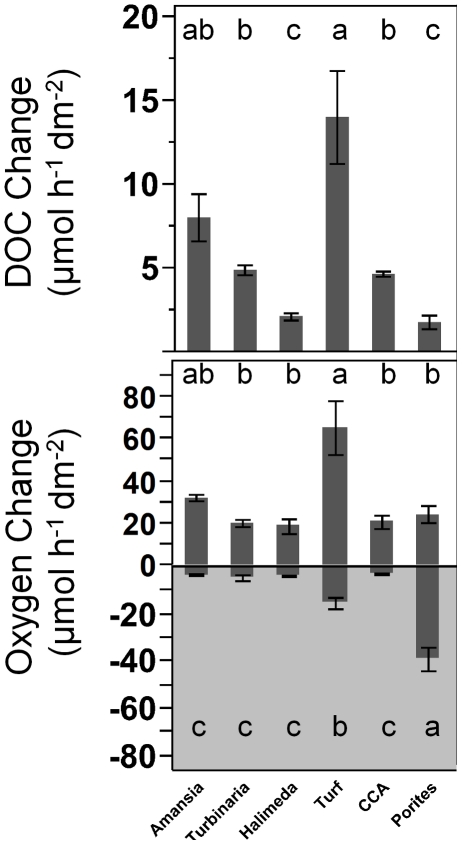
Rates of DOC production and DO production and consumption, normalized to surface area of benthic primary producers.Bars are means with standard error whiskers. Panels with grey background shading are dark incubations. A) Rates of DOC production during 8 h daylight incubation and B) oxygen production and consumption over a 24 hour light/dark cycle; treatments with the same letter are not significantly different at α = 0.05.